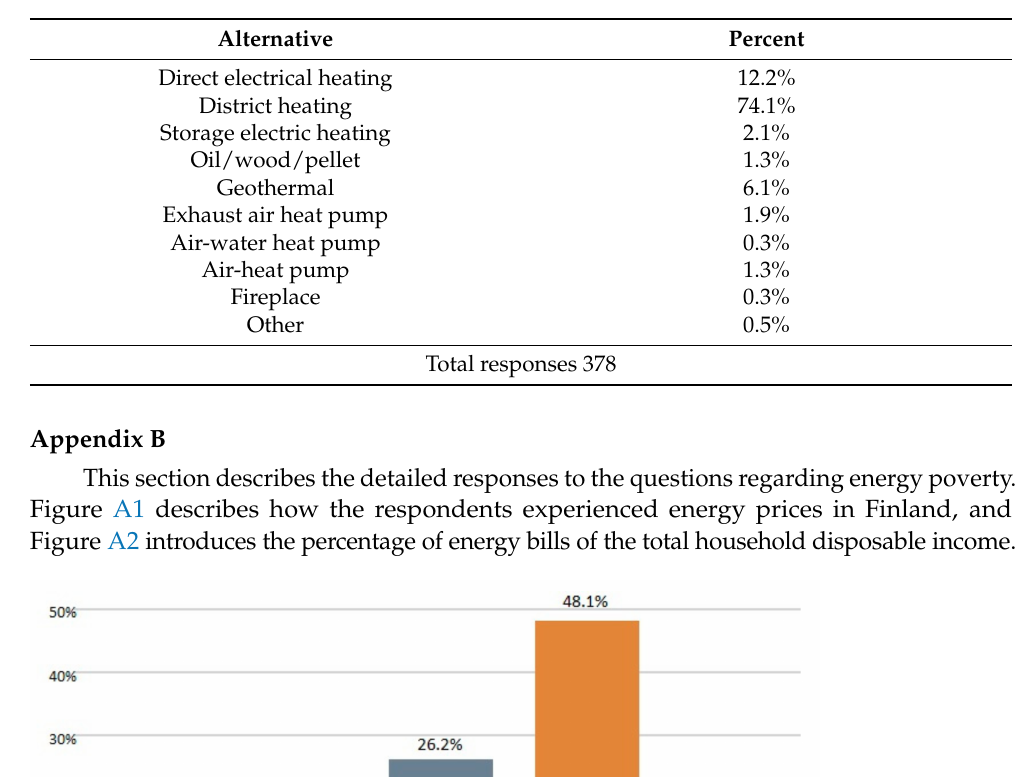
Table A2. The main heating method of the respondents.